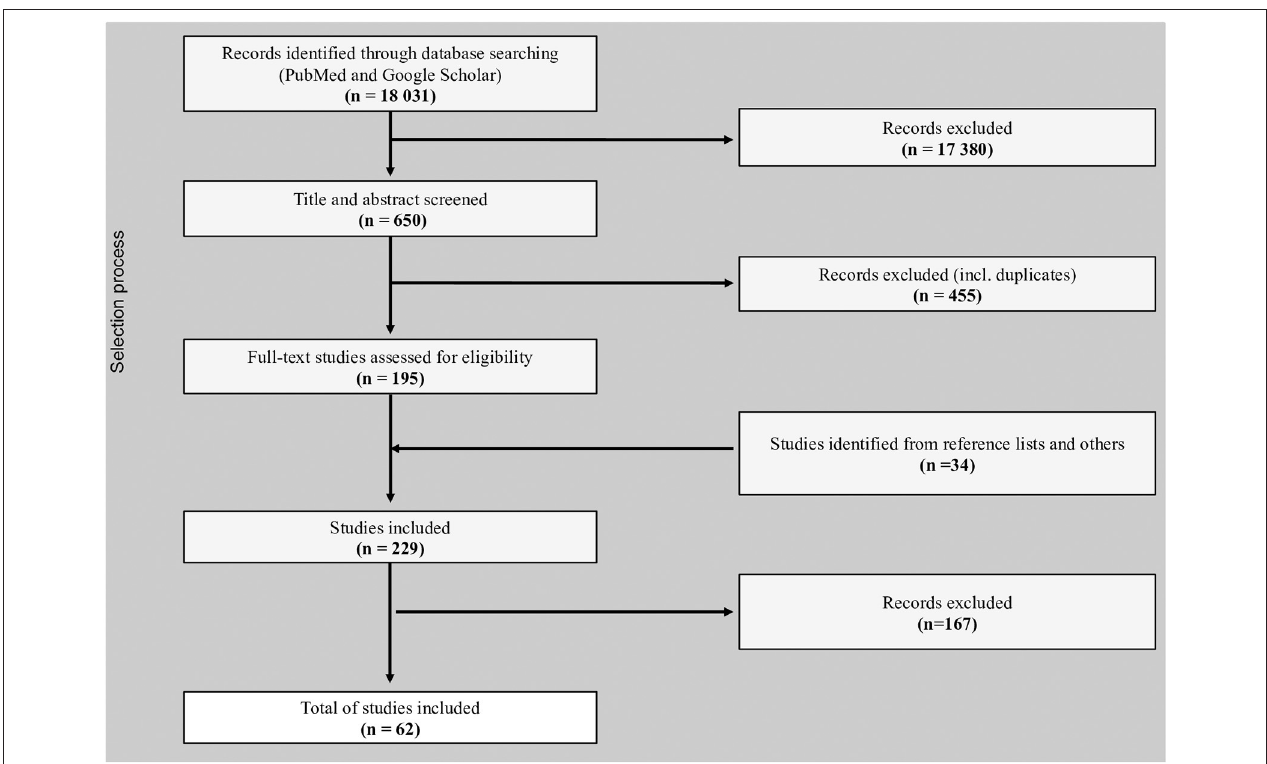
FIGURE 1 | Flow diagram of the stages of the selection process indicating the number of publications at each